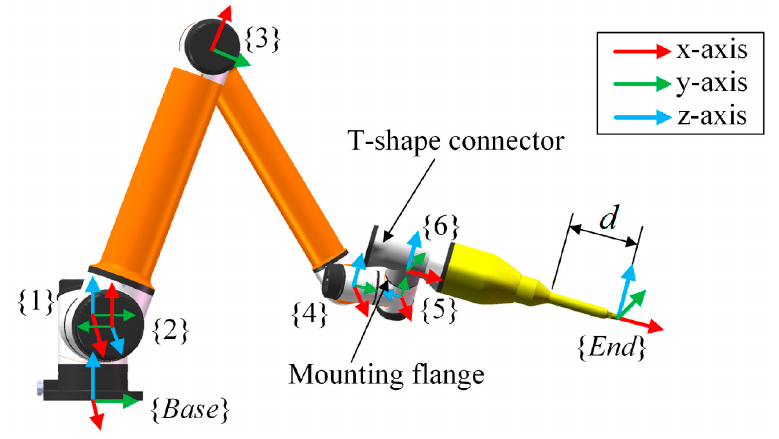
Figure 10. Definition of D-H coordinate systems from joint1 to joint6.